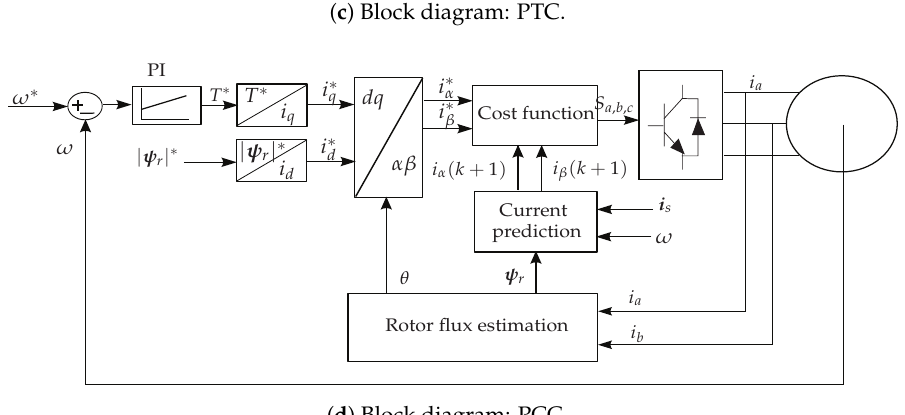
( c ) Block diagram: PTC.